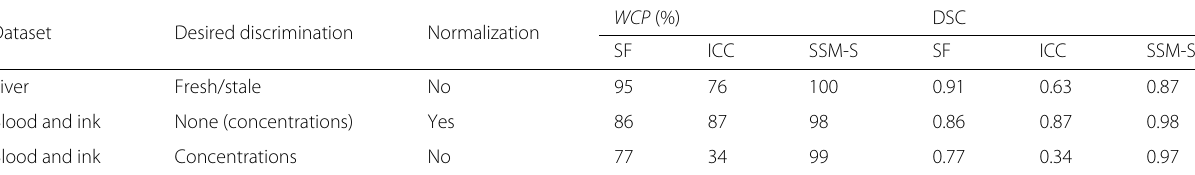
Table 2 Performance of the discriminations for spectral fitting (SF) [7], intra-class correlation (ICC) [9, 10], and the spatio-spectral mean-shift (SSM-S) algorithm, considering two evaluation criteria: the percentage of well-clustered pixels (where WCP is the value) and the Dice similarity coefficient (DSC)